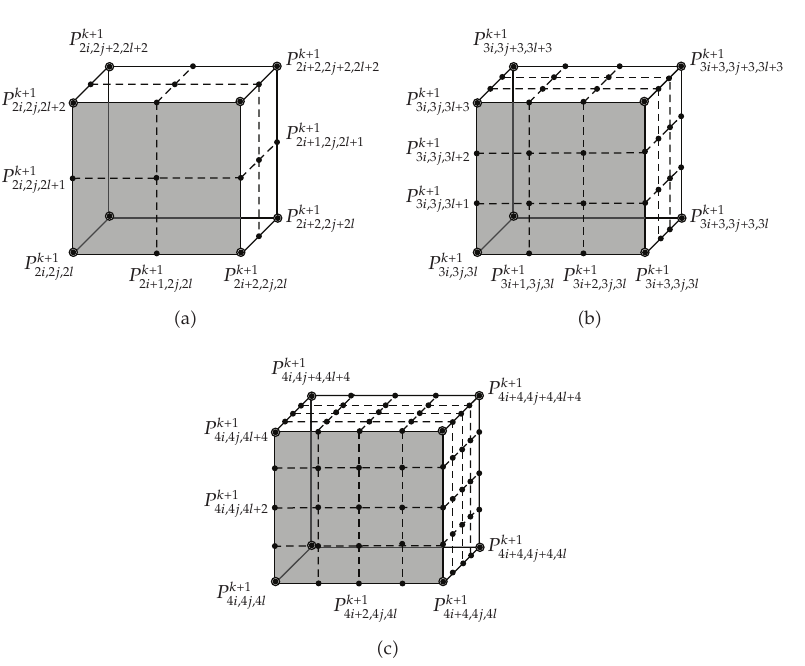
Figure 3: Solid lines show one cube of coarse polygons whereas doted lines are refined polygons. (cid:3) a (cid:4) – (cid:3) c (cid:4) can be obtain by subdividing one cube into 2 3 , 3 3 , and 4 3 new cubes by using (cid:3) 2.4 (cid:4) for n (cid:9) 2 , 3 , 4,